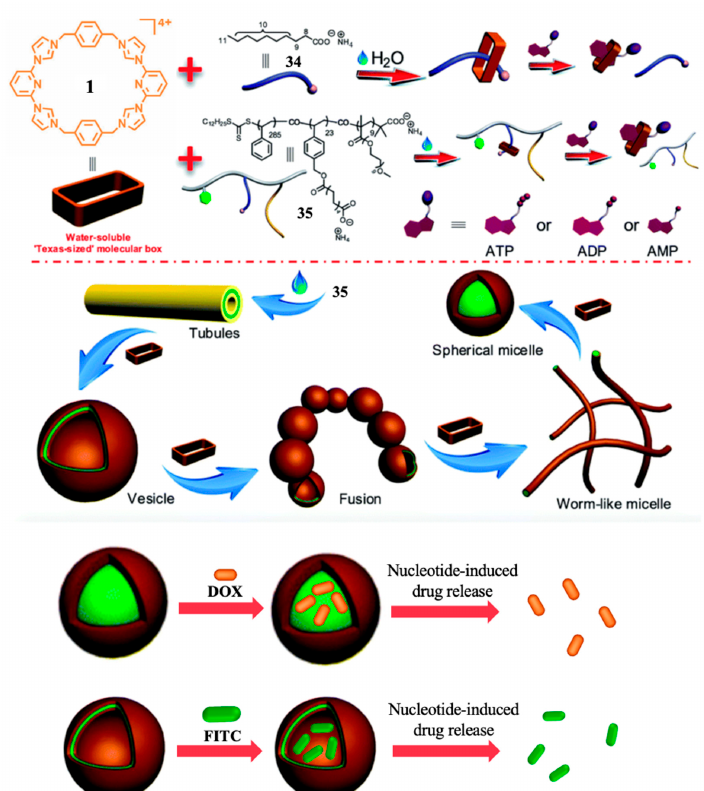
Figure 11. Chemical structures and cartoon representation of nucleotides-responsive host–guest interactions, schematic views of the diverse assemblies formed from 1 and 11 due to the molecular recognition, and nucleotide-induced drug release. Modified with permission from a figure that first appeared in ref. [57]. Copyright 2016 The Royal Society of